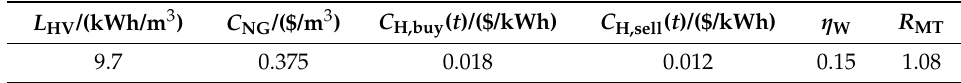
Table 5. Other parameters.